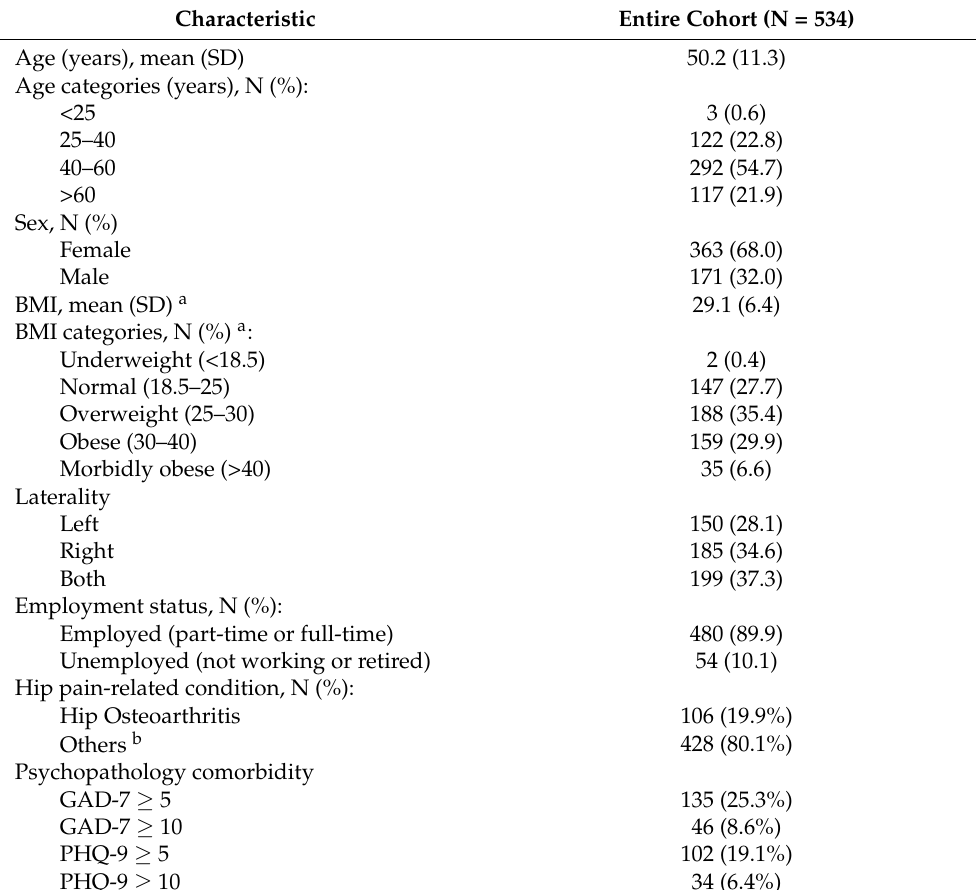
Table 2. Outcome changes between baseline and end-of-program: Intent-to-treat approach (unconditional model).